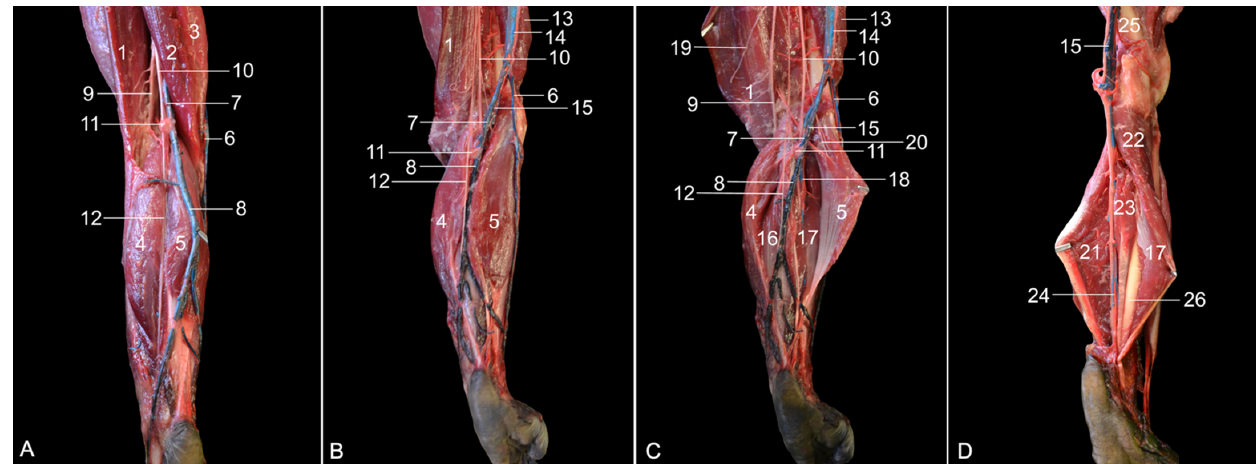
Figure 6. Caudal views of the left popliteal region. ( A ) Superficial layer in which the m. gracilis is re- moved and the v. saphena lateralis is retracted medially; ( B ) second layer after the m. semitendinosus, the m. semimembranosus and the adductor muscles were resected, showing the natural position of the v. saphena lateralis; ( C ) third layer after lateral retraction of the m. biceps femoris and after the lateral and medial heads of the gastrocnemius muscle were widely splayed; ( D ) deepest layer after the m. gastrocnemius caput laterale and caput mediale and the m. soleus were removed. 1: